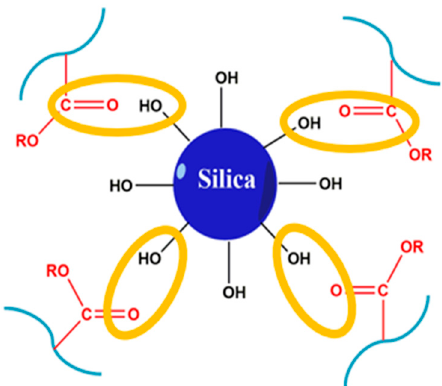
Figure 6. Schematic diagram of the hydrogen bonding interaction between itaconate elastomer and silica.